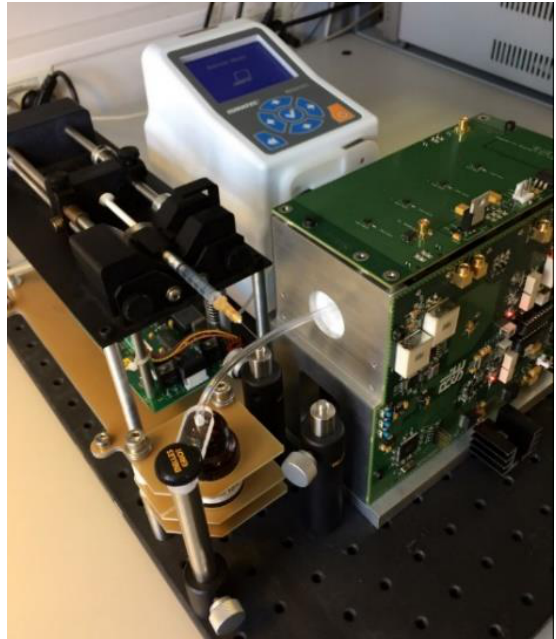
Figure 2. The complete ACS system showing the coil system, electronics and the peristaltic pump system. The peristaltic pump introduces the MNP/RCA sample plug in the sample tube and moves the sample into the detection coil systems. The coil system is behind the electronic parts. A syringe pump is also available as an alternative way to introduce the sample plug into the measurement channel.